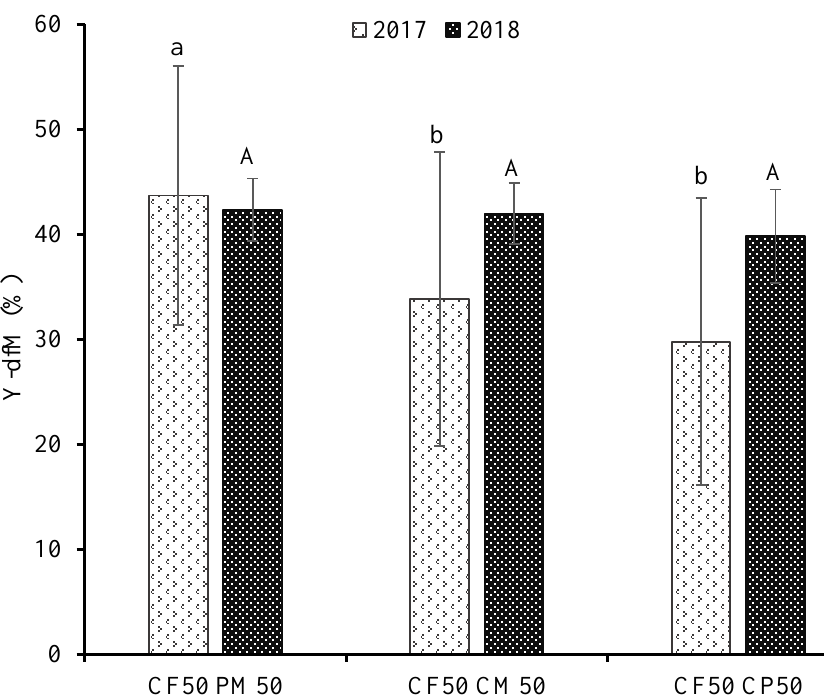
Figure 5. Yield of rice variety Manawthukha derived from manure (Y-dfM; %) as affected by organic fertilizers as EMN method. The histograms with the same letter in the same case in each year are not significantly different by the Tukey HSD test ( p < 0.05). Y-dfM (%) = Yield [(50% organic + 50% inorganic) – 50% inorganic] ÷ Yield (50% organic + 50% inorganic) × 100. Vertical bars represent SD of 3 samples.